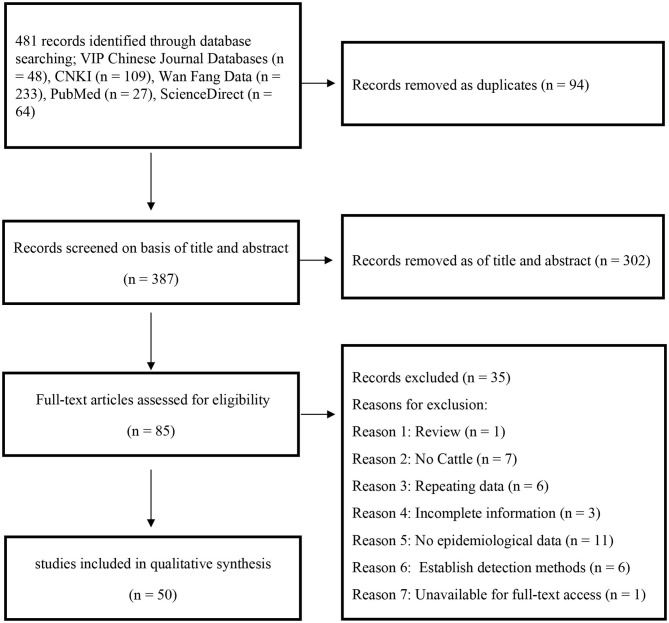
PRISMA chart of the study selection process showing inclusion and exclusion of studies.